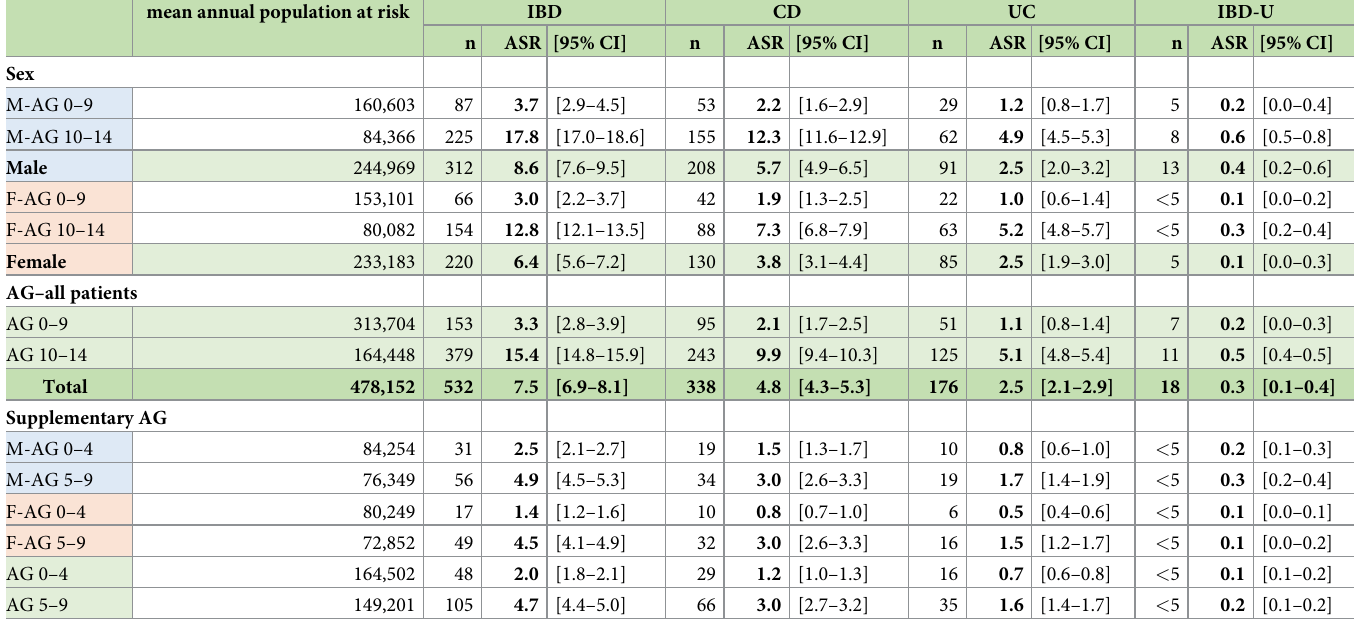
Table 1. Age-standardized incidence rates (ASR) (sex and age-specific) of inflammatory bowel disease (IBD), Crohn’s disease (CD), ulcerative colitis (UC) and unclassified IBD (IBD-U) per 100,000 person-years (PY) in Saxony. Total rates, sex-specific rates and age-specific incidence rates in age groups (AG) per year.